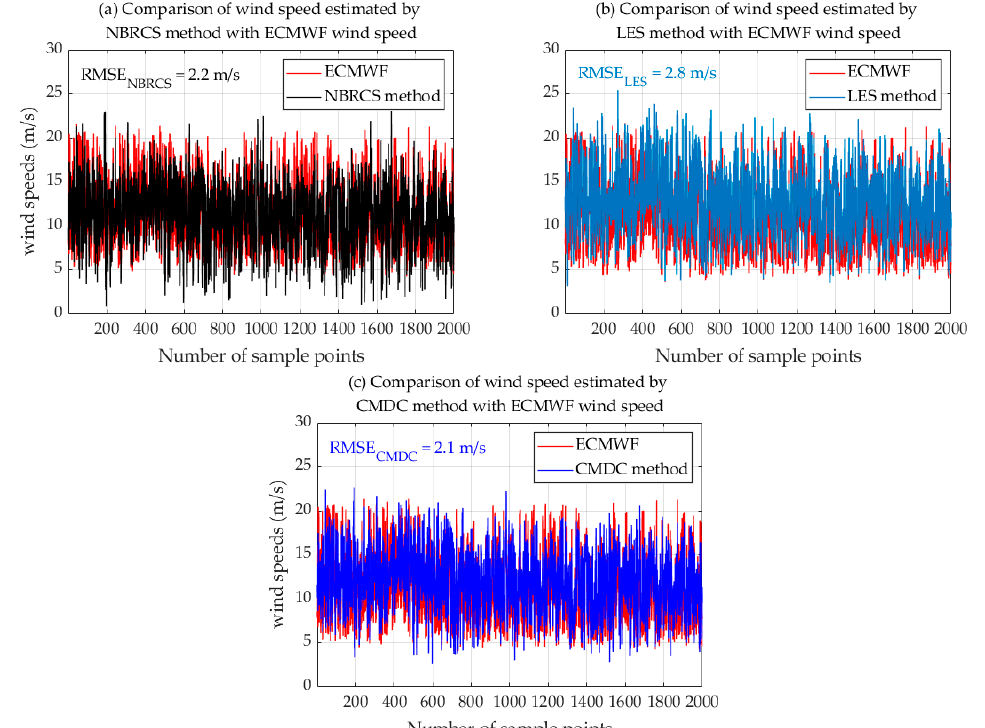
Figure 16. Comparison of wind speed estimated by CMDC, NBRCS, and LES methods with ECMWF wind speed. ( a ) Comparison of wind speed estimated by NBRCS method with ECMWF wind speed, ( b ) Comparison of wind speed estimated by LES method with ECMWF wind speed, and ( c ) Comparison of wind speed estimated by CMDC method with ECMWF wind speed.